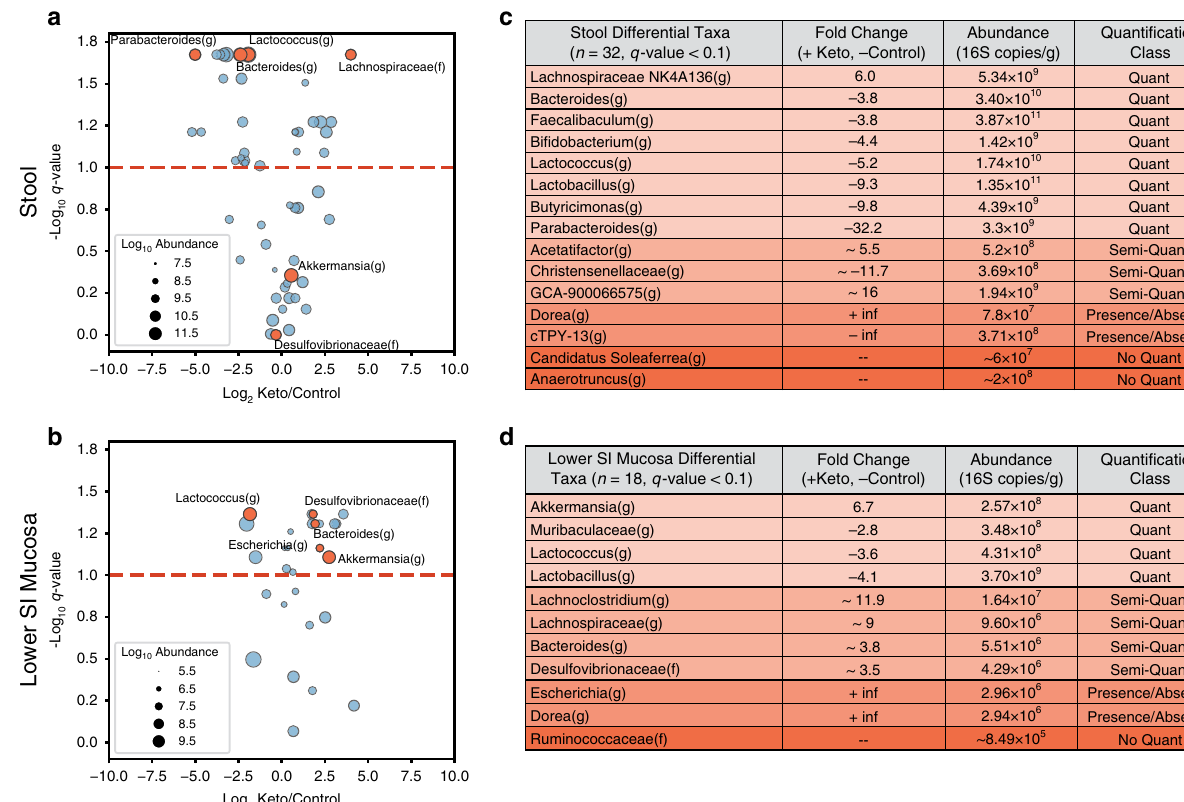
Fig. 6 Incorporating quanti fi cation limits enhances differential taxon analysis as shown in stool and SI mucosa. A quantitative framework that explicitly incorporates limits of quanti fi cation separates differential microbial taxa into four classes, and for each GI location identi fi es a distinct set of differential taxa, including taxa with opposite patterns in stool and SI mucosa. a , b Microbial taxa in stool ( a ) or lower small-intestine ( b ) mucosa in mice on ketogenic ( N = 6) and control ( N = 6) diets. The fold change on the x -axis is the Log 2 ratio of the average absolute loads of taxon loads in each diet. Negative values indicate lower loads in ketogenic diet compared with control diet. The q -value for a taxon indicates the signi fi cance of the difference in absolute abundances between the two diets and was obtained by Kruskal – Wallis with a Benjamini – Hochberg correction for multiple hypothesis testing. The Log 10 absolute abundance of each taxon is indicated by circle size. Orange circles indicate taxa discussed in the main text, including taxa that show discordant fold changes between stool and lower SI mucosa. The red dashed line is shown at a q -value representing a 10% false-discovery rate. c , d A subset of taxa from stool ( c ) and lower SI mucosa ( d ) that were signi fi cantly different between diets ( q -values < 0.1) and their corresponding fold change, absolute abundance (larger of the average absolute abundances between the two diets), and quanti fi cation class. Quanti fi cation class is determined by whether one or both measurements were above or below the lower limit of quanti fi cation and the limit of